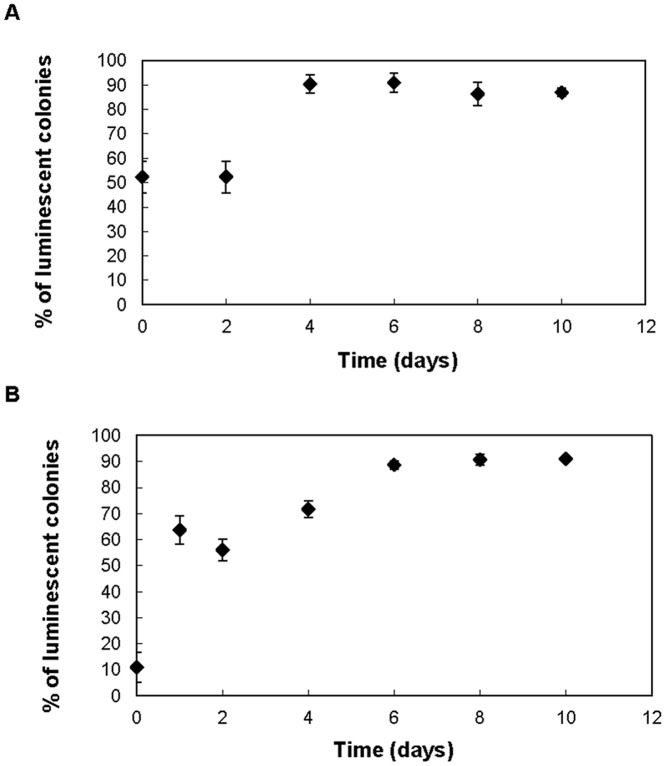
Impact of luxI deletion on competition in Vibrio fischeri.Percentage of luminescence colonies plated from mixed V. fischeri MJ1 (wild type) and MJ211 (luxI mutant) cultures subcultured daily for ten days. The starting ratio of MJ1 to MJ211 was either 1∶1 (Panel A) or 1∶9 (Panel B). Regardless of the initial ratio of wild type (MJ1) to mutant (MJ211) cells, the wild type lineage dominated the cultures within days suggesting the luxI gene represents a selective advantage independent of the bioluminescence phenotype. Average values from triplicate cultures are presented. Error bars represent standard deviation.